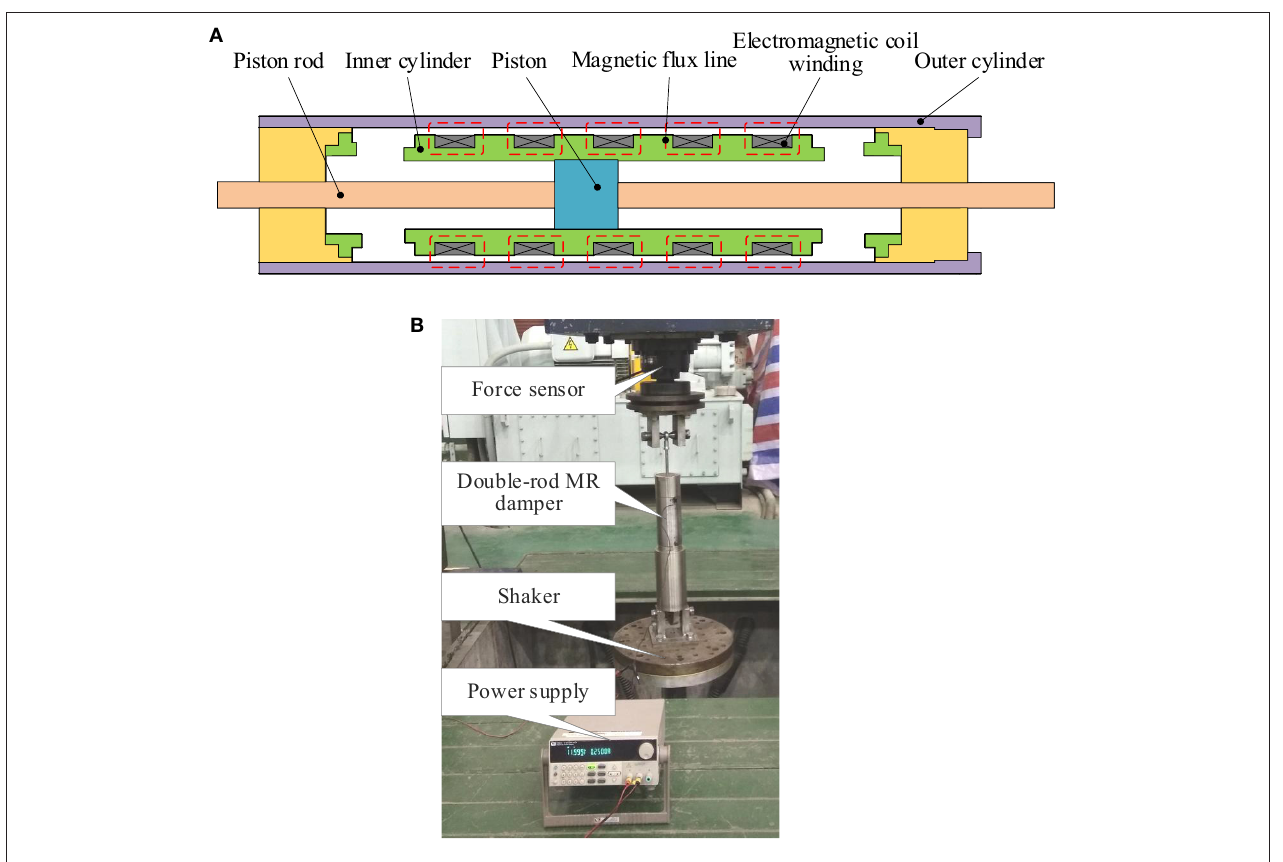
FIGURE 1 | The self-developed double-rod MR damper: (A) schematic and (B) experimental setup.